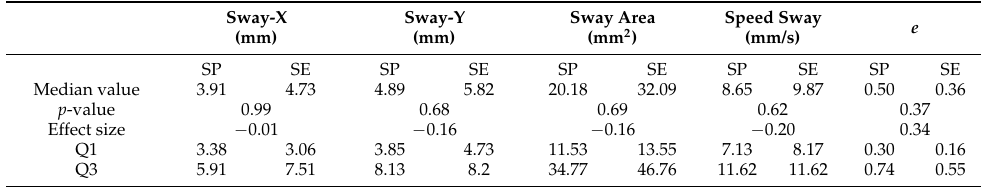
Table 2. The sway parameter of the Centre of Pressure (COP) in standing position (SP) and during the performance of self-elongation (SE). All values are shown as median and